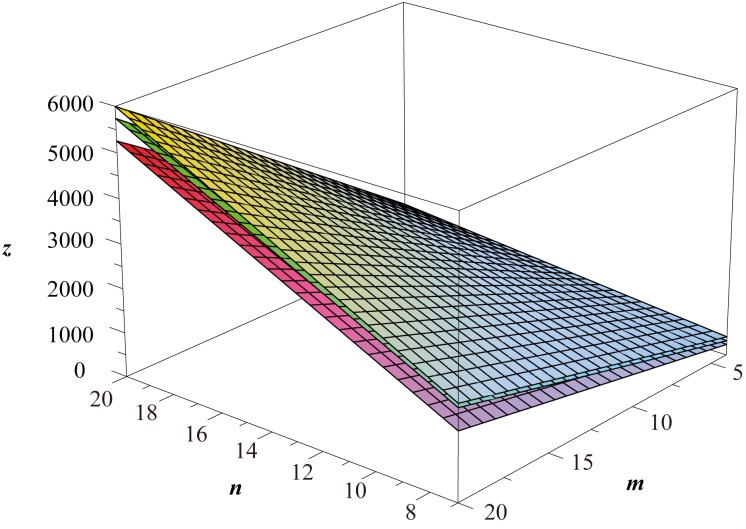
The Wiener polarity index of St(n, m), Sc(n, m) and Sf(n, m).